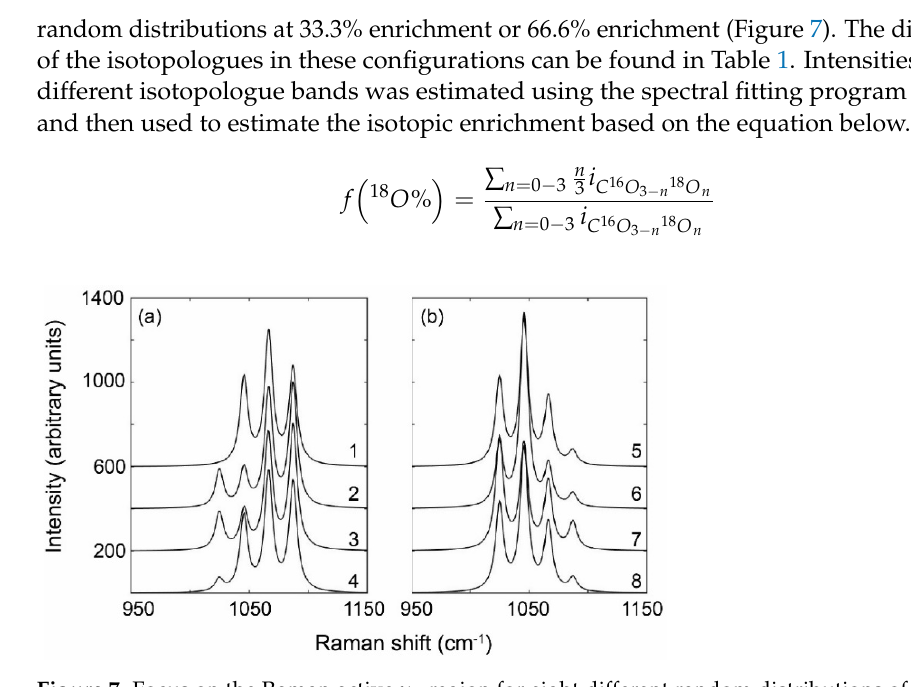
Figure 7. Focus on the Raman active υ 1 region for eight different random distributions of 18 O within the calcite structure at either 33% ( a ) or 66% ( b ) enrichment. Note, the spectra have been offset by 200 counts to aid visualization of the different isotopologue distributions. Table 1. Calculated 18 O enrichment from simulated Raman spectra of randomly distributed 18 O producing eight different isotopologue distributions at either 33 or 66% enrichment. Total O atoms in the supercell was